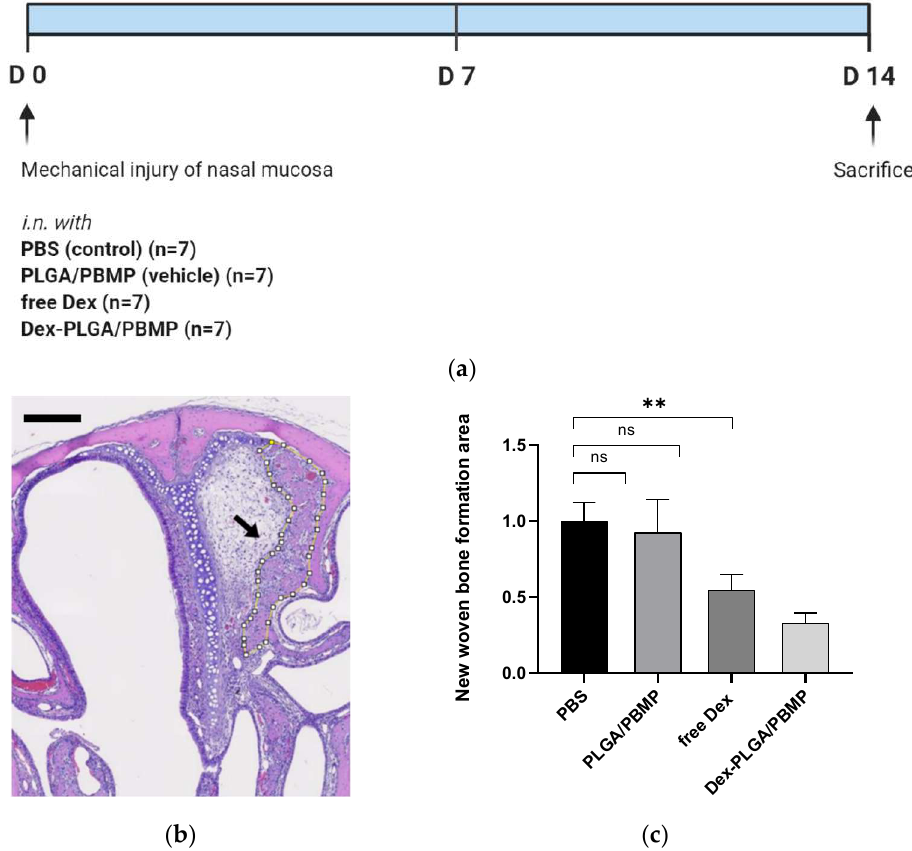
Figure 5. ( a ) Schematic illustration of the in vivo study protocol: Dex (Dexamethasone); PLGA/PBMP (empty PLGA/PBMP particles); Dex-PLGA/PBMP (Dex-loaded PLGA/PBMP parti- cles); i.n . (intranasal). ( b ) A representative H&E-stained image for the estimation of new bone for- mation area (dotted yellow line) in the sinonasal cavity of the mouse model treated with PBS only . The scale bar represents 500 μm. ( c ) Relative area of woven bone formation. The bar indicates the mean ± SEM of the area of woven bond formation ( n = 7). The statistical analysis was performed using one-way ANOVA test. ** indicates p < 0.01 and ns means not significant. We compared the osteocalcin activity of the nasal septum and the nasoturbinate area using immunohistochemistry (IHC). The relative numbers of osteocalcin-positive cells are compared in Figure 6. Similar to the results of the new woven bone formation, free Dex and Dex-loaded PLGA/PBMP showed approximately 30%–50% of osteocalcin activity compared to the PBS control. However, unlike the bone formation results, free Dex showed the lowest osteocalcin activity, followed by Dex-loaded PLGA/PBMP. ( a ) ( b ) Figure 6. Comparison of osteocalcin activity in the IHC images of the sinonasal cavity treated with various formulations. ( a ) Representative antibody-stained images image showing the osteoblast- related bone regeneration in the mucosal defect area. The black arrows show the osteocalcin-posi- tive cells. The scale bar represents 500 μm. ( b ) Relative osteocalcin activity. The relative numbers of osteocalcin-positive cells were compared. The bar indicates the mean ± SEM ( n = 7). The statistical analysis was performed using one-way ANOVA test. ** and *** indicate p < 0.01 and p < 0.001, re- spectively. ns means not significant.